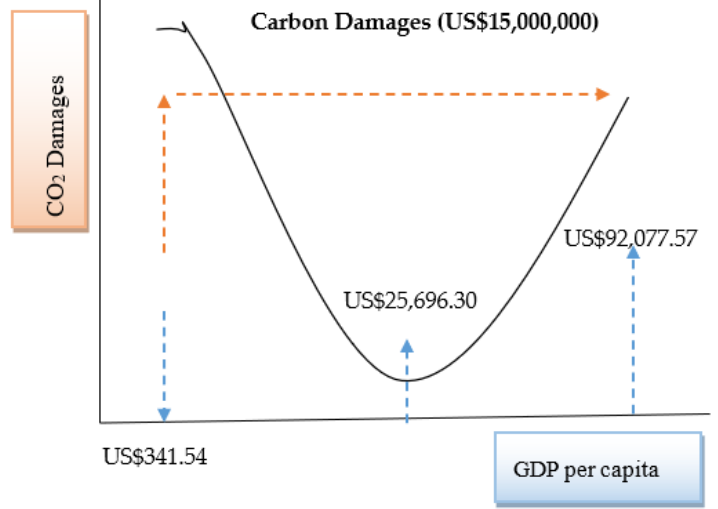
Figure 5. U-shaped Curve between Carbon Damages and Economic Growth.